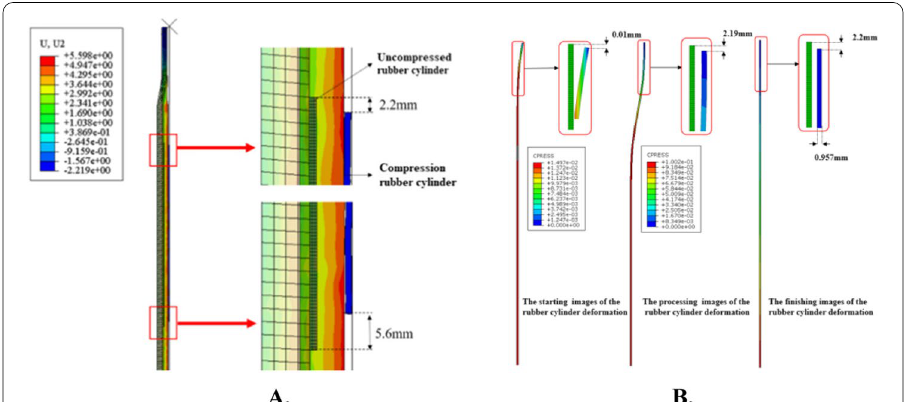
cylinder along with the expansion